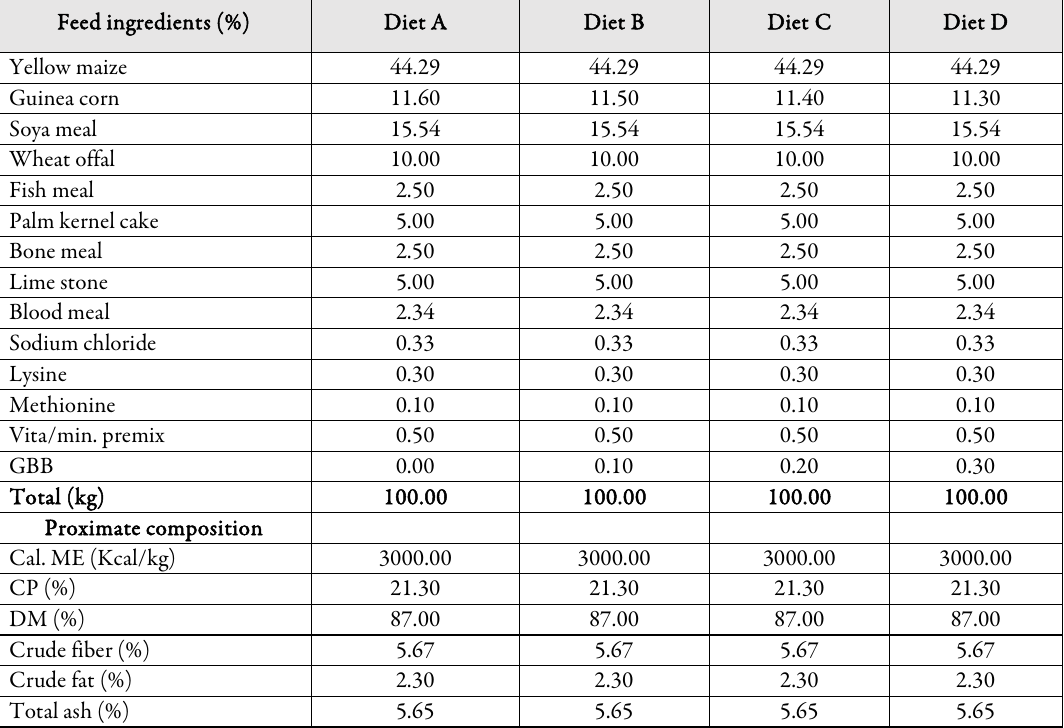
Table 1. Ingredients and proximate composition of pig starter diet supplemented with graded levels of